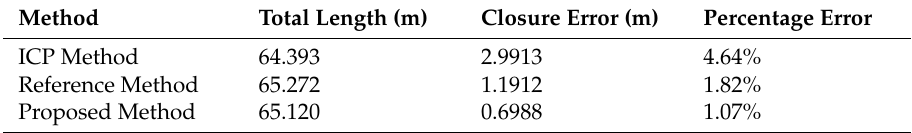
Table 6. Localization results of ICP method, reference method and our proposed method